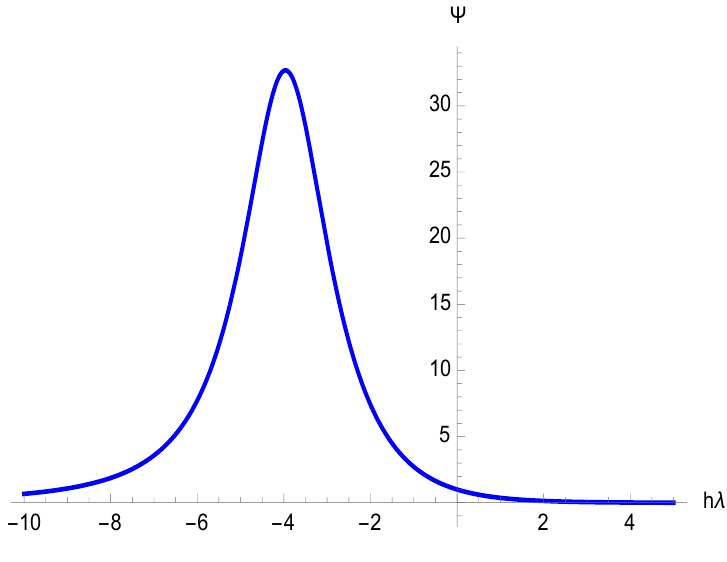
Figure 1. Root of characteristic